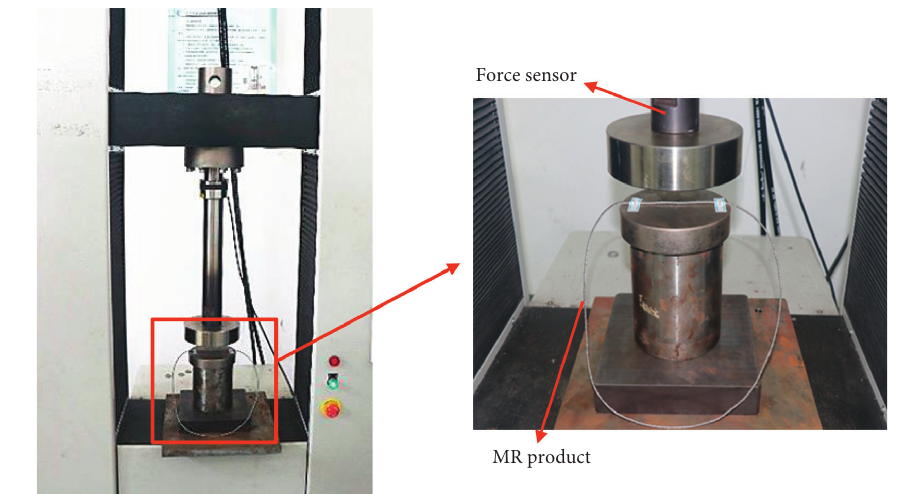
Figure 7: MRSM quasi-static loading-unloading